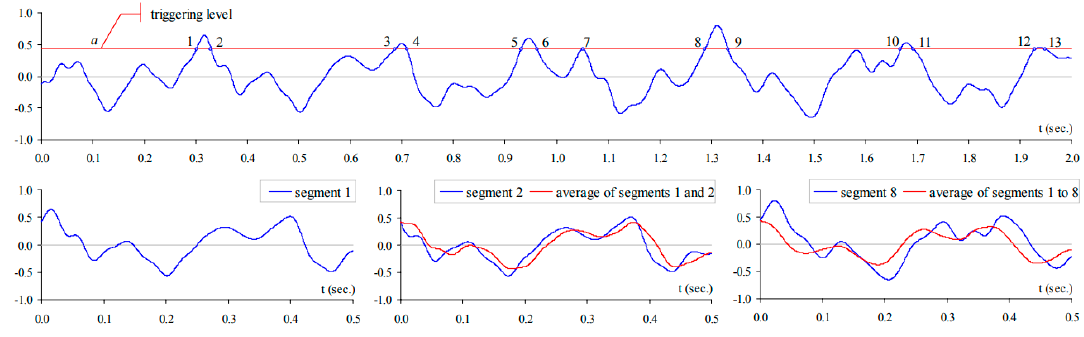
Figure 9. Basic concept of the RDT after [74].